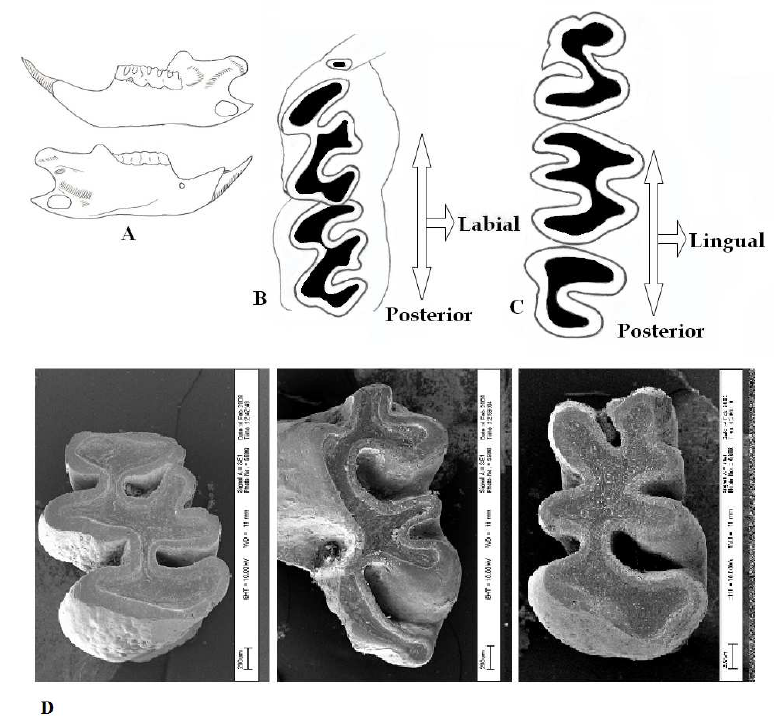
FIGURE 14 : A) Allactaga mandibles B) Upper tooth row in Allactaga C) Lower tooth row in Jaculus . D) Electron microscope image of Allactaga